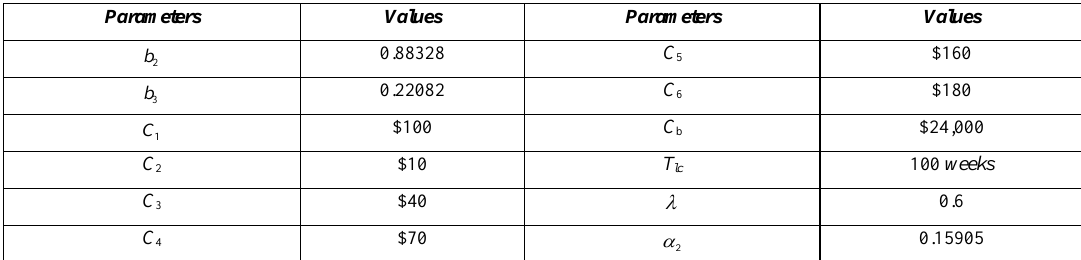
Table 1. Parameter